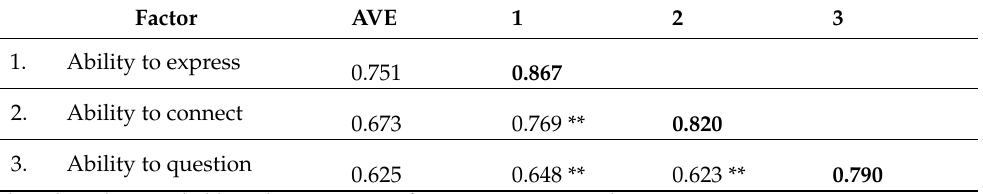
Table 4. Average variance extracted, square root of AVE, and matrix of correlations between factors for